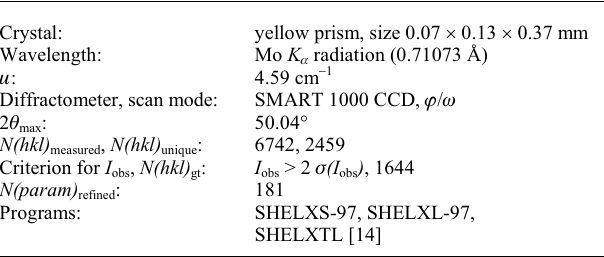
The title crystal structure was determined by X-ray crystallogra- phy. The title crystal structure is only built up by the C H Cl N O molecules, in which all bond lengths are in normal 15 12 2 2 ranges. The molecule crystallizes with eight crystallographically independent molecules in the unit cell. The two benzene rings form a dihedral angle of 47.65°. In addition, in the crystal struc- ture, the crystals are held together by intermolecular O1–H1 ,,, N2 hydrogen bonds [12,13]. The distance between N2 and O1 is 2.965 Å. Because of the intermolecular hydrogen bonds, the title compound formed an infinite 1D supramolecular structure along the c axis. Table 1. Data collection and handling.